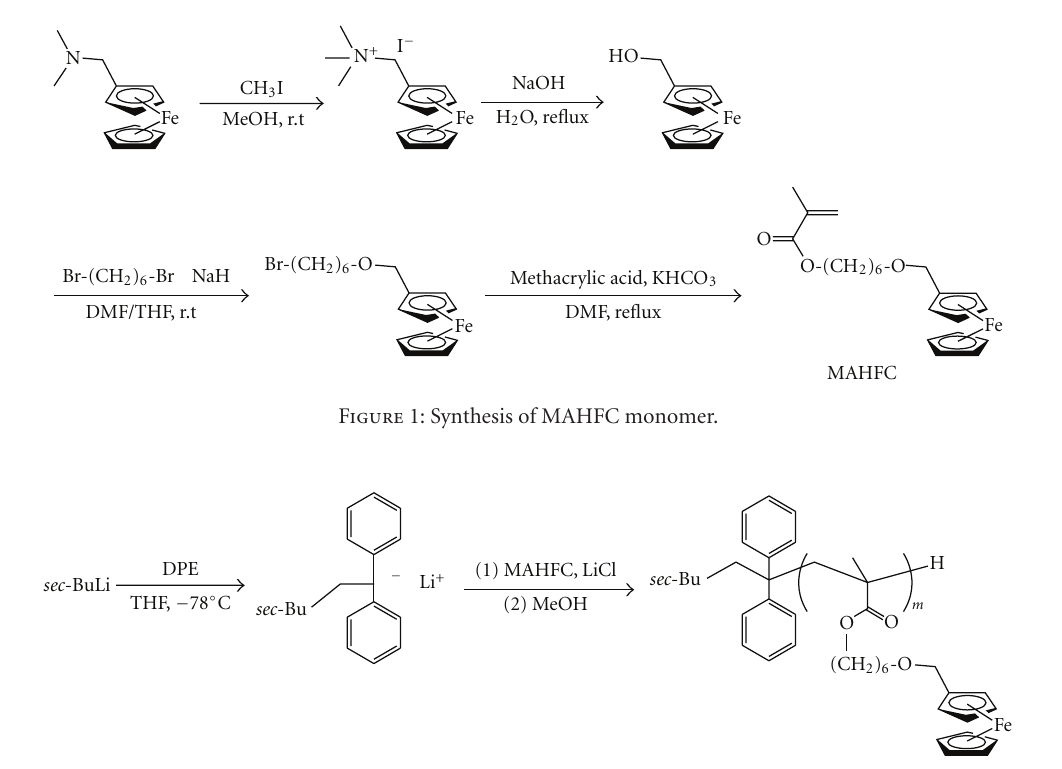
Figure 2: Synthesis of PMAHFC homopolymer by living anion